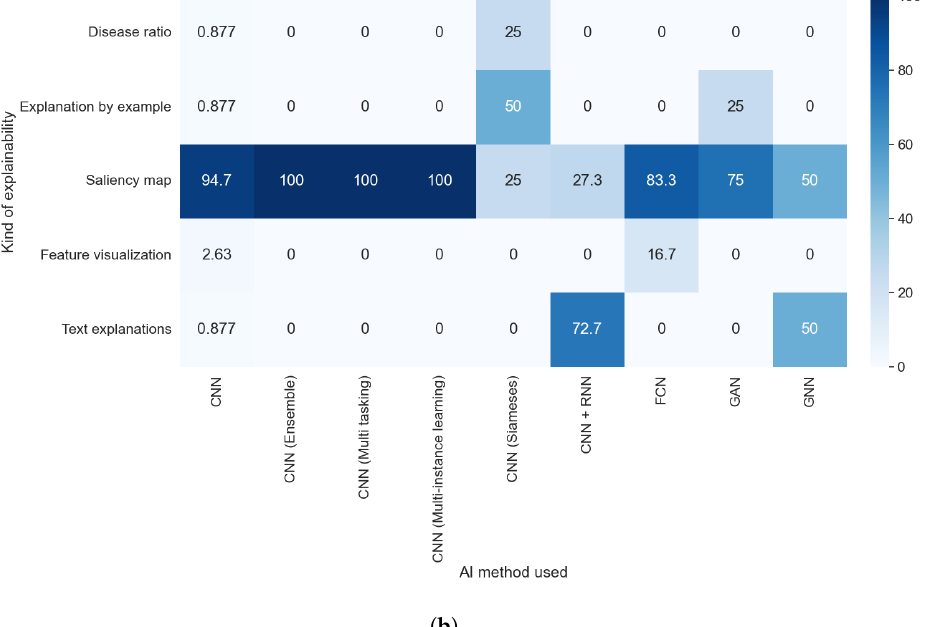
Figure 18. Heat maps comparing the results of RQ2 and RQ7. ( a ) In absolute values; ( b ) normalized results by column, values in percentages.